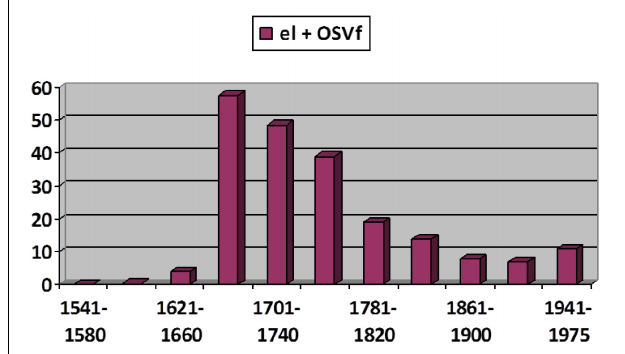
FIGURE 5 | Diffusion of the use of the article ( el “the.M.SG”) before clauses introduced by que “that” presented as a weighted frequency by time period. Data from CORDE (Octavio de Toledo y Huerta, 2014b).